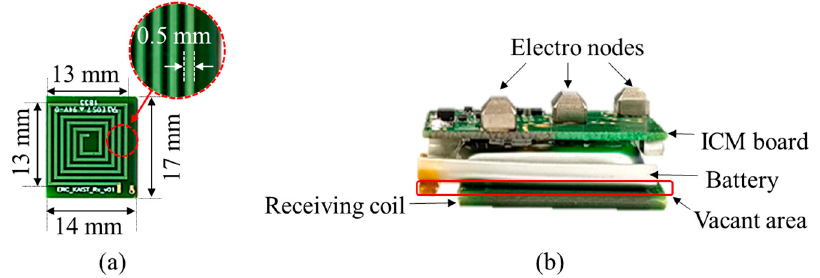
Figure 11. Fabricated receiving coil and measurement setup. ( a ) Photograph of fabricated receiving coil. ( b ) Stacked view to mimic the battery effect.